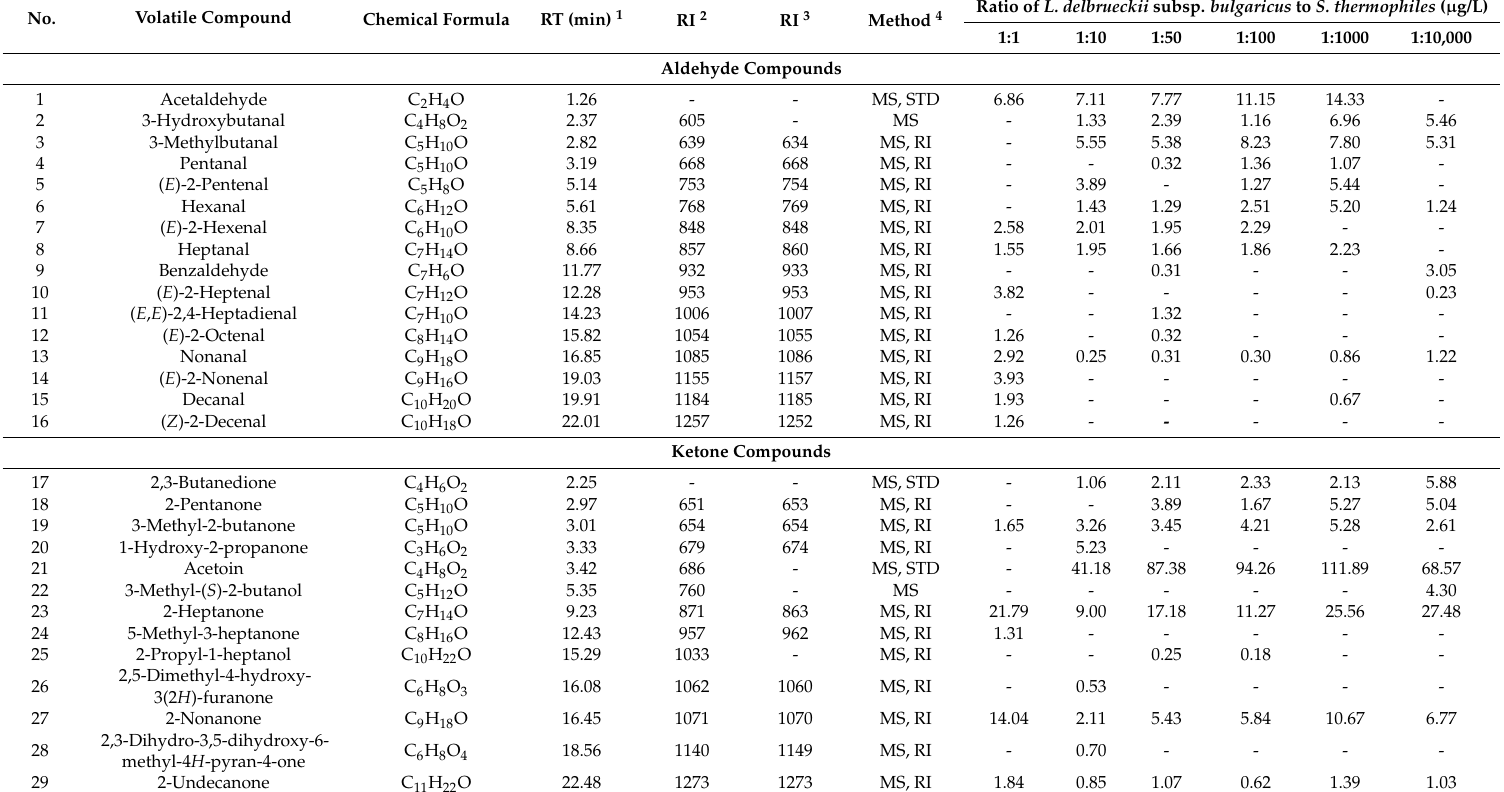
Table 1. Volatile compounds produced by milk fermented with different proportions of L. delbrueckii subsp. bulgaricus IMAU20401 and S. thermophilus ND03. Ratio of L. delbrueckii subsp. bulgaricus to S. thermophiles ( µ No. Volatile Compound Chemical Formula RT (min) 1 RI 2 RI 3 Method 4